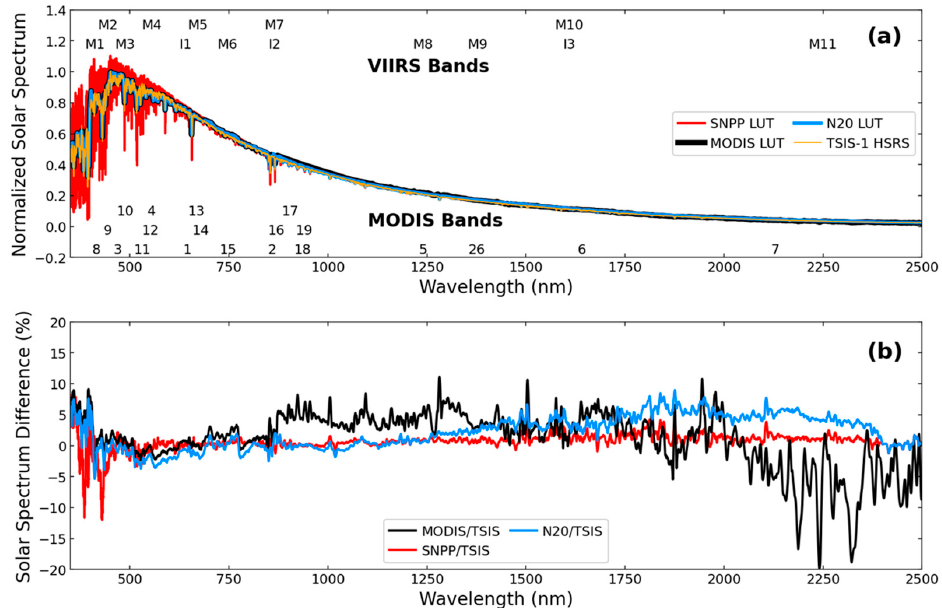
Figure 5. ( a ) Solar spectrum for MODIS (same for both Terra and Aqua), SNPP VIIRS, N20 VIIRS, and the TSIS-1 HSRS. The data were normalized to the peak value of the MODIS LUT. Band locations are marked according to their wavelengths at the top (VIIRS) or bottom (MODIS) of the figure. ( b ) Percentage difference of each of the instrument solar spectrum LUTs compared to the TSIS-1 HSRS data. A 10 nm smoothing window was applied to these differences for clarity at the lower wavelengths.